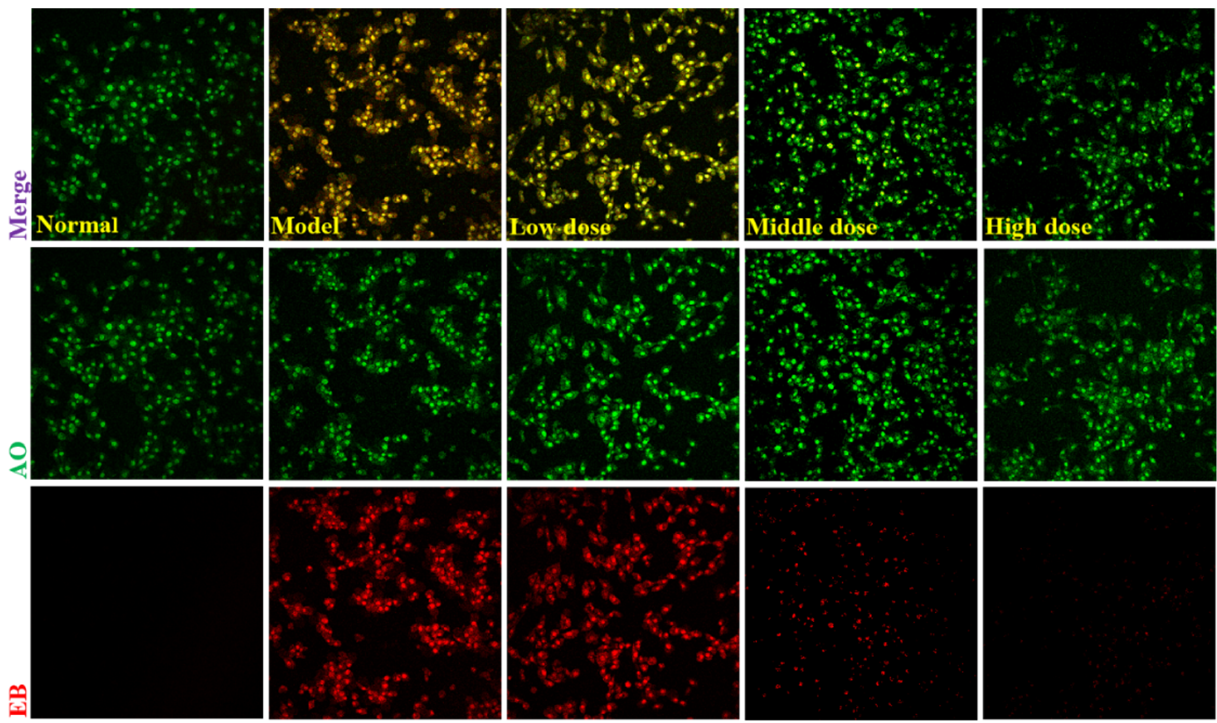
Figure 9. Apoptotic assay by AO-EB staining (×20). Cells were pretreated with SMP (4%, 8%, and 16%) for 24 h and then incubated in the presence of H 2 O 2 (100 µ M) for 24 h. SMP: Salvia miltiorrhiza-containing plasma. The results were observed using laser confocal microscopy under a 20 ×